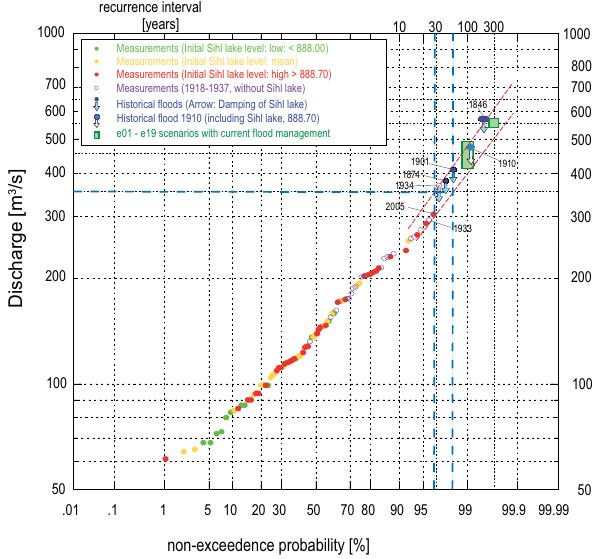
Figure 4. The frequency diagram at the station Sihl-Sihlhölzli in Zurich (Kienzler et al., 2013). Measurements before (1918–1937) and after the construction of the Sihl Lake reservoir (1938–2011) are presented. Different colours signalize the initial level of the Sihl Lake before the event. Historical floods are indicated in blue. For sake of representativeness the light blue arrows show and estima- tion of the expected damping by the reservoir in the case of his- torical floods. The green boxes display the range of the calculated peak discharge with PREVAH (Table 1). The red dashed line shows the proposed flood discharges for different recurrence intervals. The blue lines illustrate the range of return period for the 350m 3 s − 1 flood threshold.